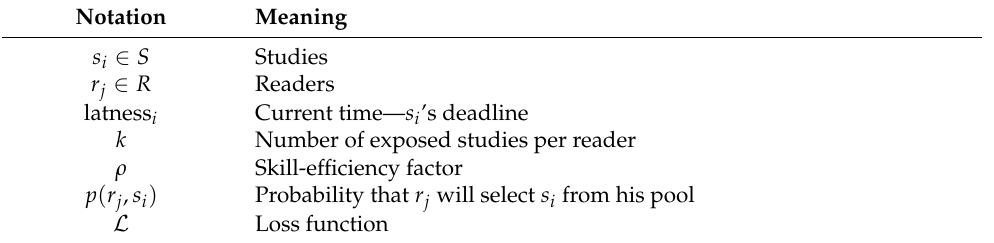
Table 4. Summary of key